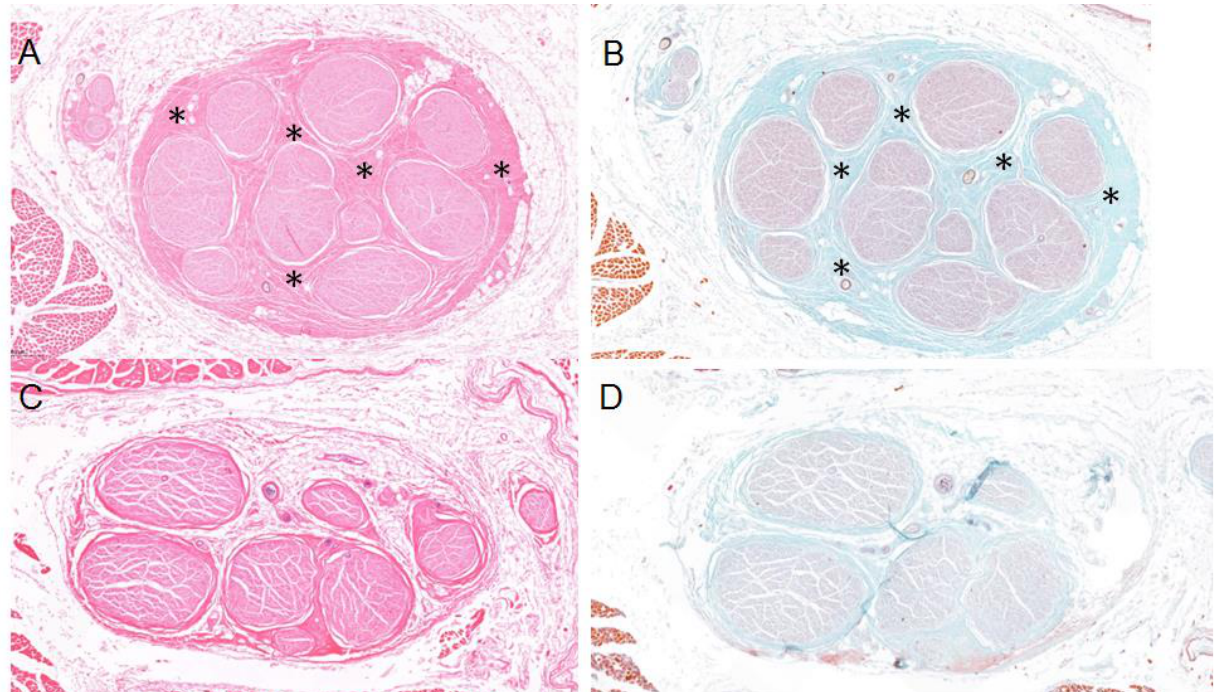
Figure 9. Histology samples of the UN in relation to the muscular variation and the fibrous tissue (black asterisks) can be observed between nerve fascicles (NF) as a sign of chronic extrinsic compres- sion, stained with haematoxylin-eosin ( A ) and with Masson’s trichrome ( B ). Histology samples of the UN stained by haematoxylin-eosin ( C ) and Masson’s trichrome ( D ) without signs of fibrosis.